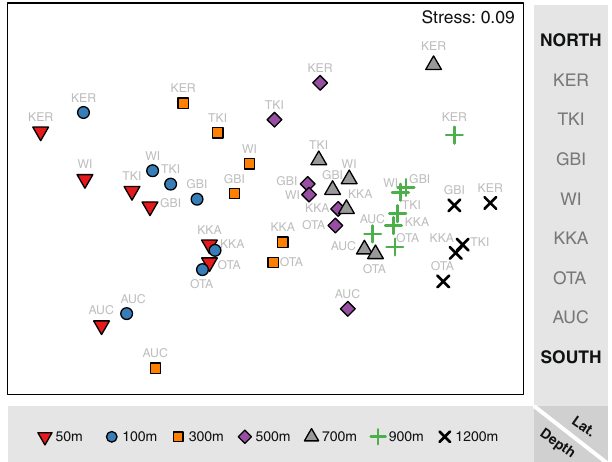
Figure 2. Ordination analysis of fish communities by depth and latitude. Non-metric multi-dimensional scaling (nMDS) ordination plot of Jaccard dissimilarities among fish assemblages consisting of depth-by- location averages (centroids) from a minimum of n = 6 video deployments (except for the Auckland Islands and White Island where no deployments were made at 1200 m). Each centroid is identified by a symbol to indicate the depth (50, 100, 300, 500, 700, 900 or 1200 m) and a label to indicate the location (from north to south: Kermadec Islands (KER), Three Kings Islands (TKI), Great Barrier Island (GBI), White Island (WI), Kaikoura (KKA), Otago (OTA) and the Auckland Islands (AUC)).